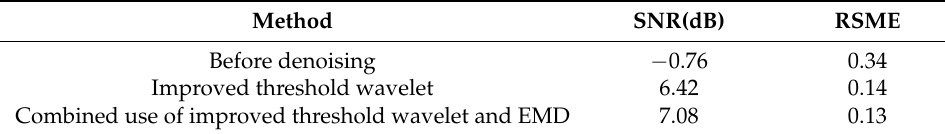
Table 4. Comparison of two denoising methods for wire rope break